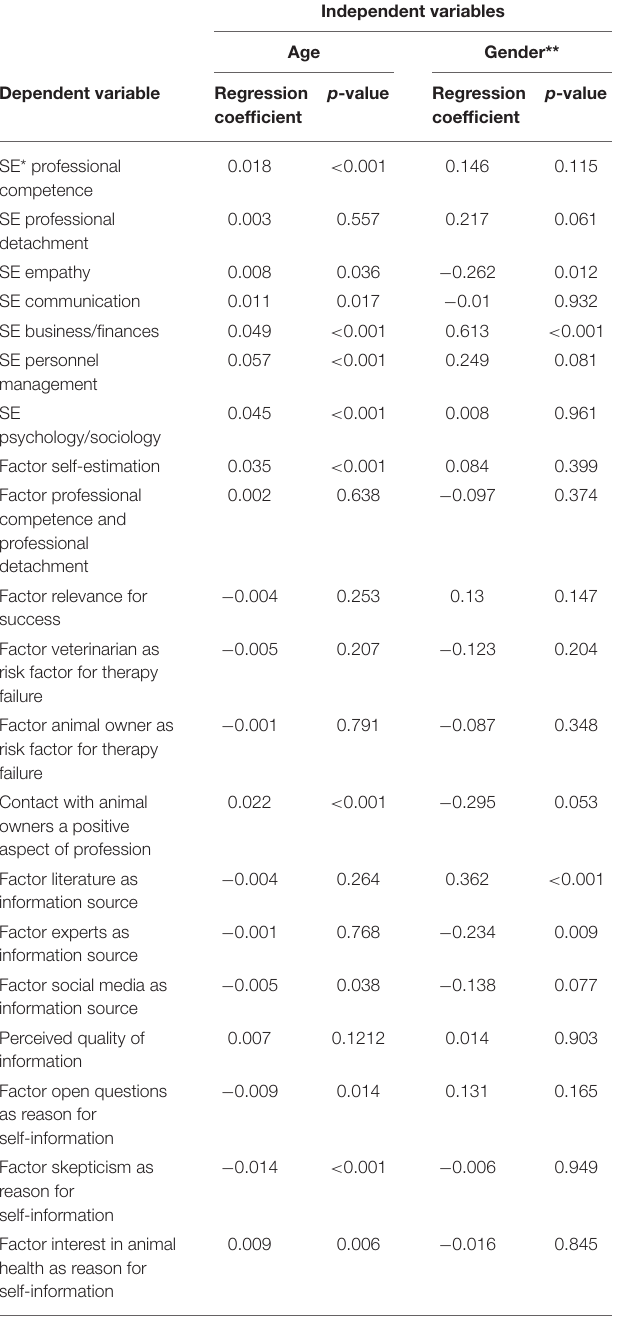
TABLE 2 | Frequencies of questionnaire items related to the factors “risk factors associated with veterinarians” and “risk factors associated with animal owners” from a survey of 527 German veterinarians.